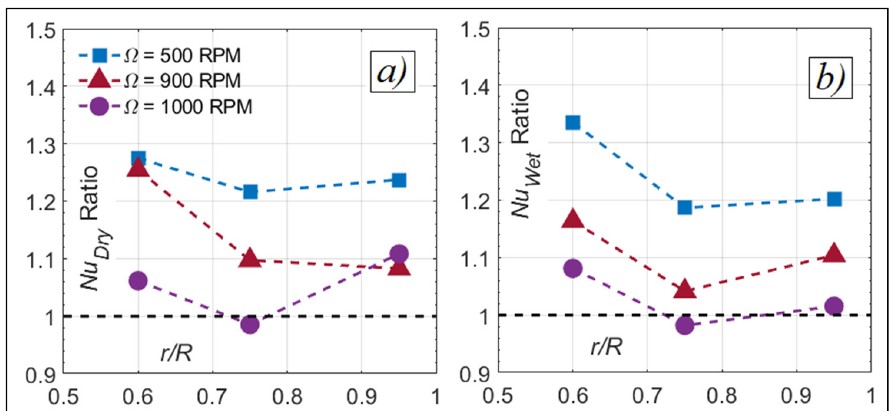
Figure 11. Ratios of the Calculated Nu between Tests at V ∝ = 30 m/s and V ∝ = 20 m/s for ( a ) the Nu Dry and ( b ) the Nu Wet.